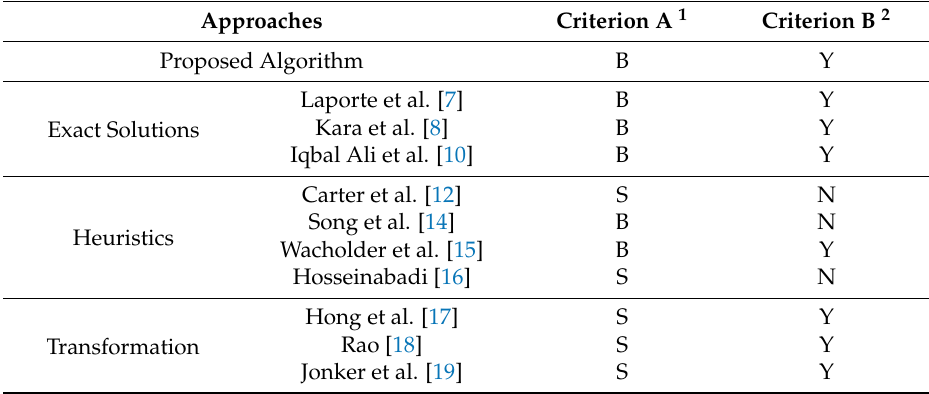
Table 9. Qualitative Comparison of the Proposed Algorithm with Other Approaches. 1 B = Both Symmetric and Asymmetric Cost Matrix, S = Symmetric Cost Matrix Only